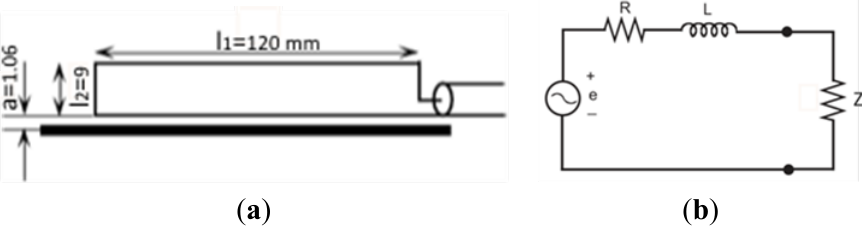
Figure 6. ( a ) ILS schematic and ( b ) its electric equivalent circuit.